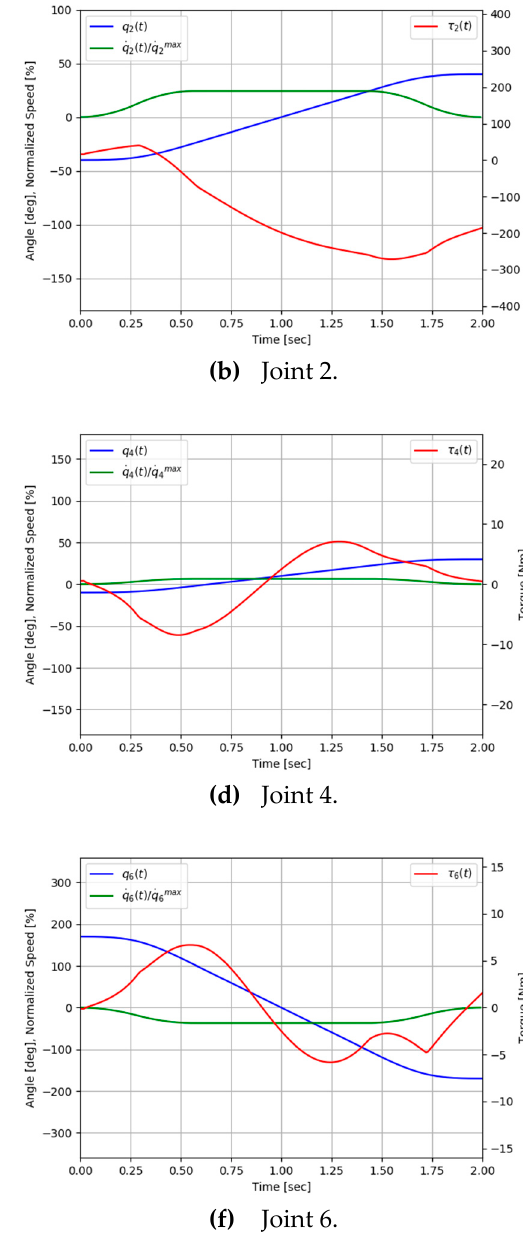
Figure 5. Joint angle, speed and torque profiles for the initial motion (Case 1).